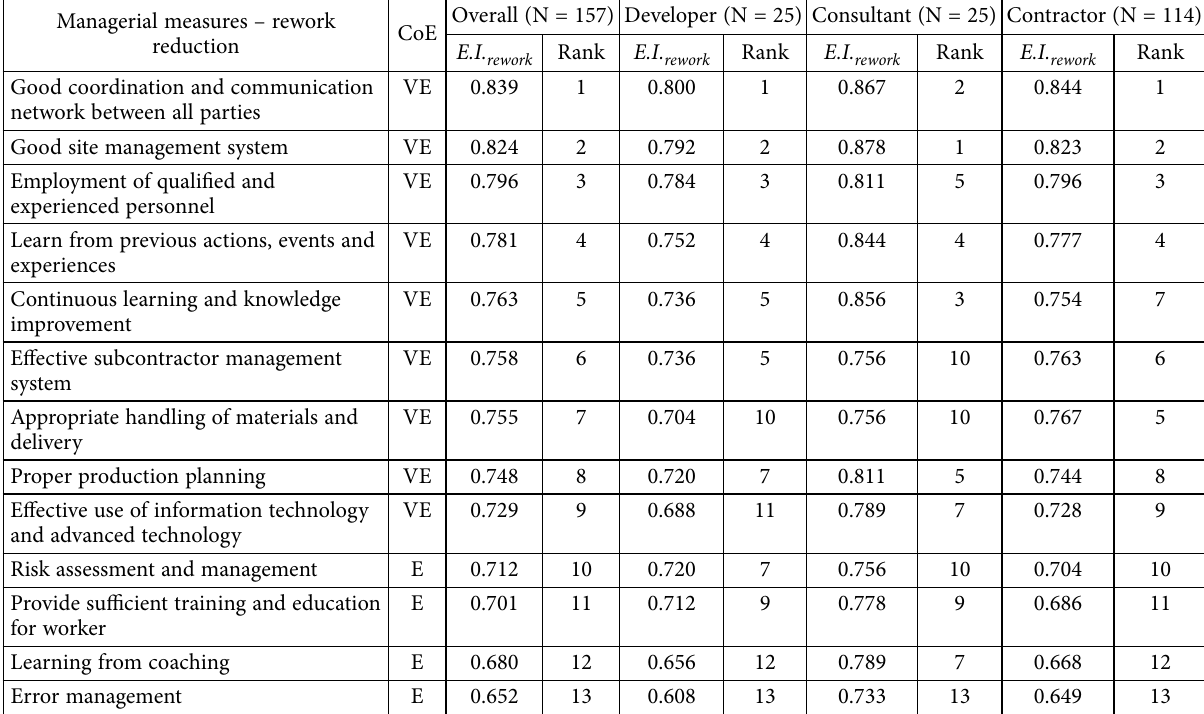
Table 3. Effectiveness index and ranking of rework management measures